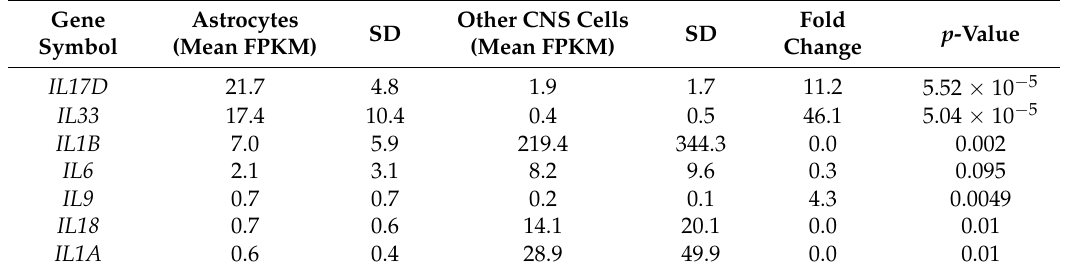
Table 5. List of interleukins that are constitutively expressed by normal mature human astrocytes.